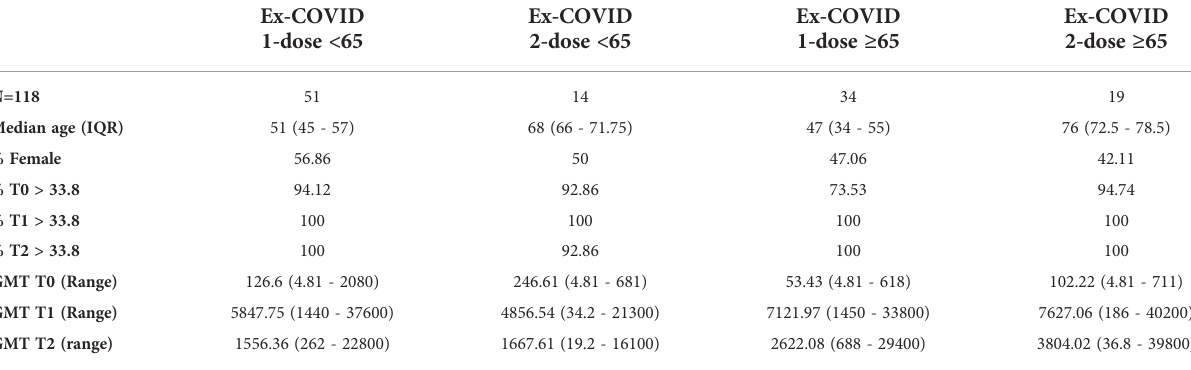
TABLE 2 Demographic characteristics, baseline values and humoral immune response induced at T1 and T2 time-points by different vaccines in healthy adults and frail elderly individuals with previously reported COVID-19 diagnosis. Ex-COVID Ex-COVID Ex-COVID Ex-COVID 1-dose <65 2-dose <65 1-dose ≥ 65 2-dose ≥